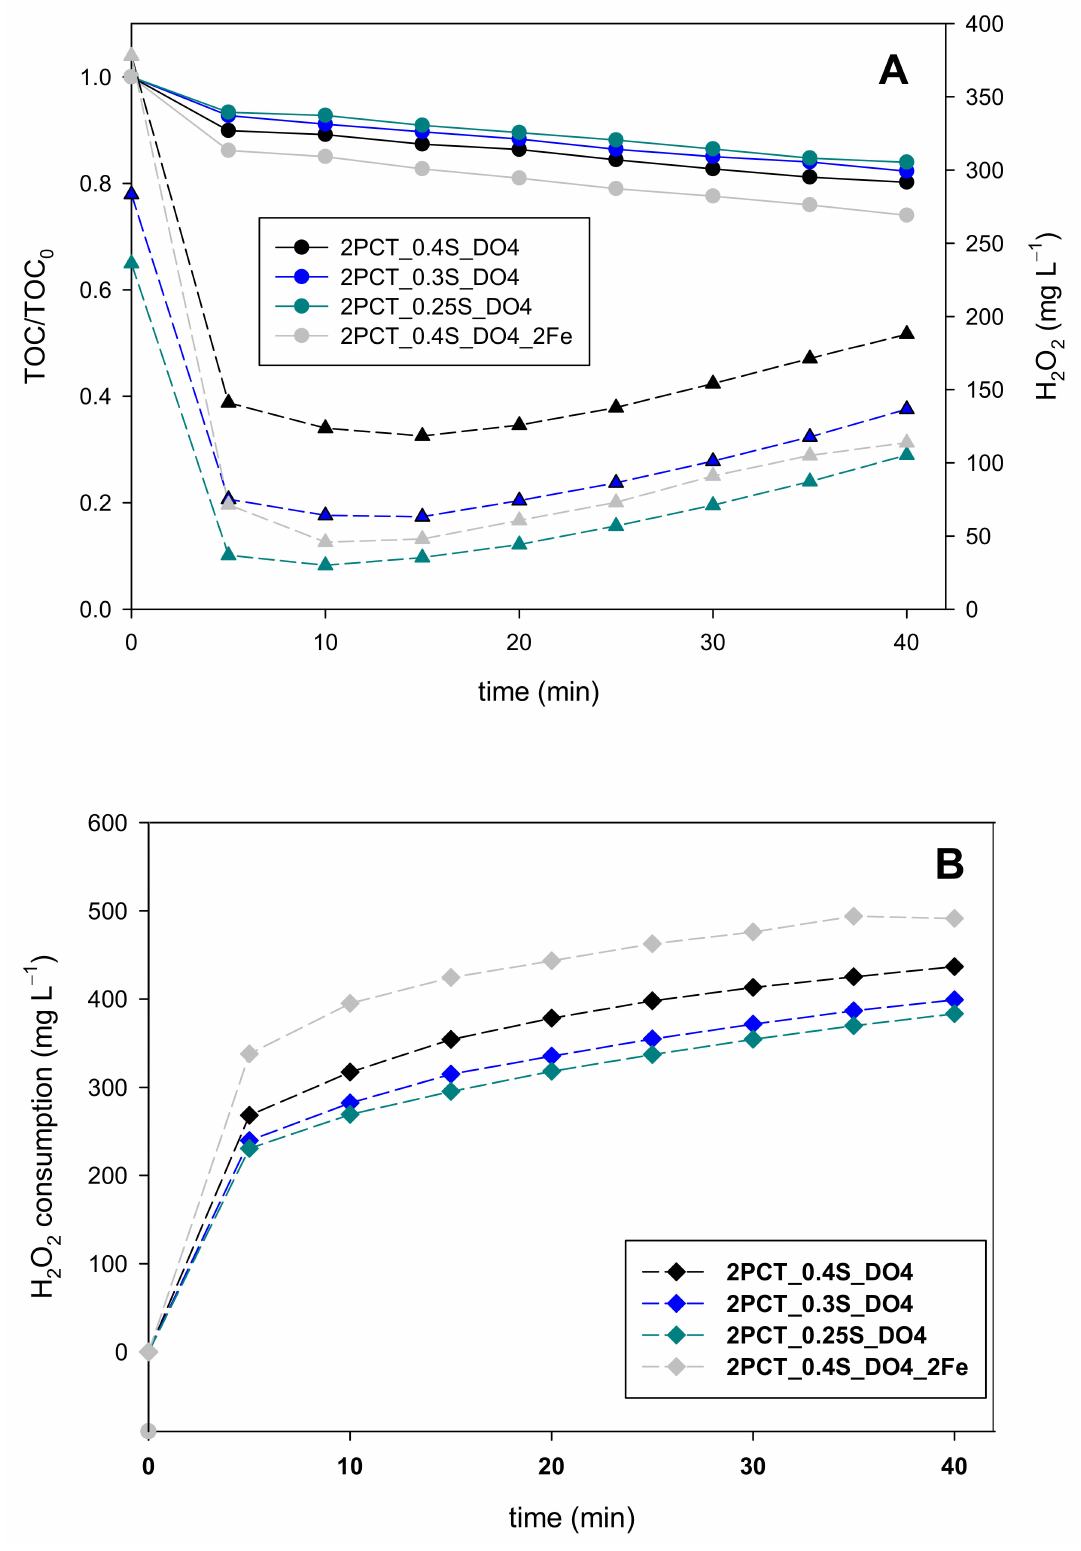
Figure 3. TOC and H 2 O 2 concentration profiles—round and triangular symbols, respectively—( A ) and H 2 O 2 consump- tion curves ( B ) obtained using 2PCT_0.25S_DO4, 2PCT_0.3S_DO4, and 2PCT_0.4S_DO4 dosage strategies, including an additional assay doubling the iron concentration